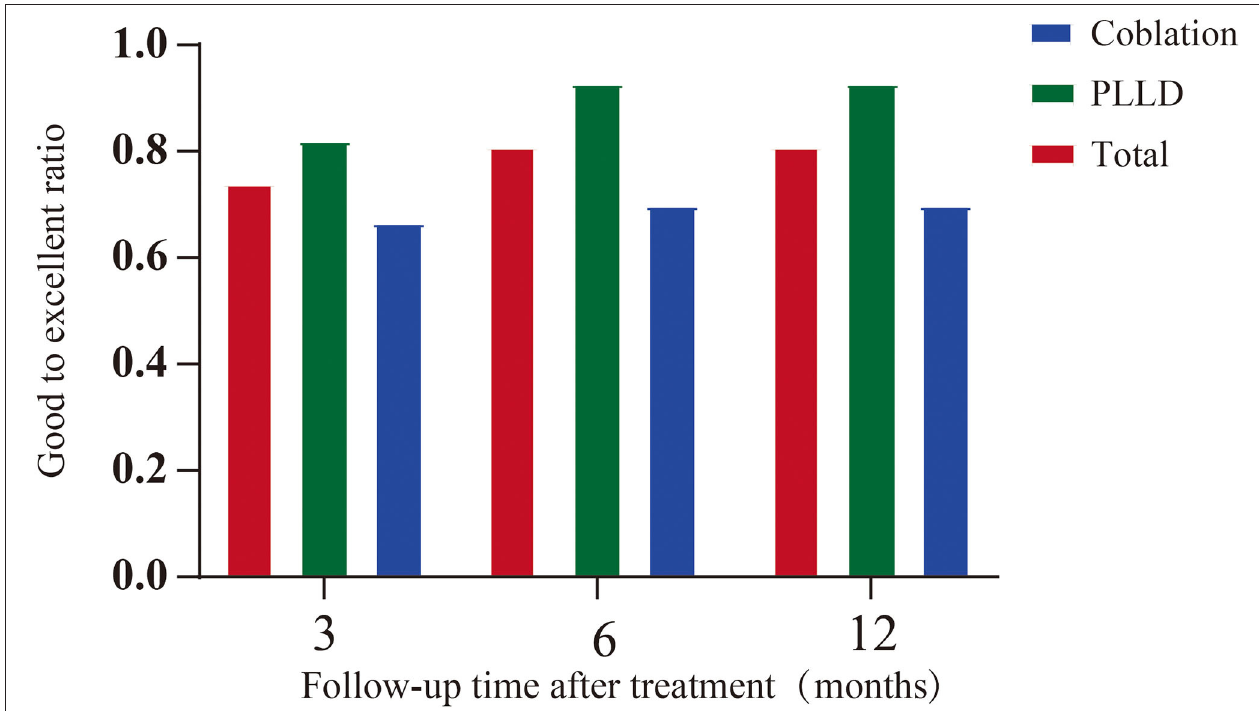
FIGURE 4 | Clinical outcome after minimally invasive surgery assessed by the modified Macnab Criteria.